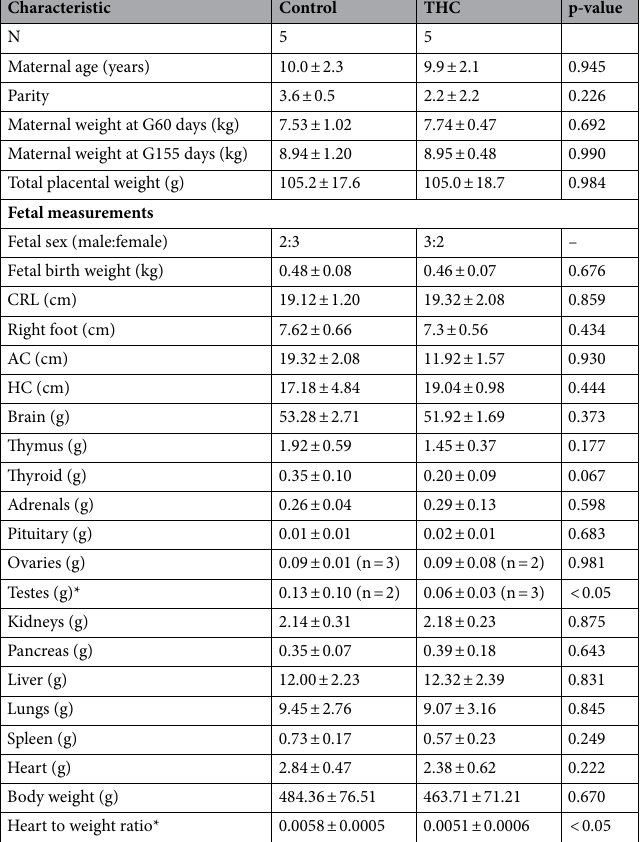
Table 2. Maternal, fetal, and placental weights and demographics. CRL crown rump length, AC abdominal circumference, HC head circumference. Tissue to fetal body weight ratio was not significant for all tissues except heart. Data are means ± SD. Statistical analysis performed using Welch’s t-test. *p < 0.05.